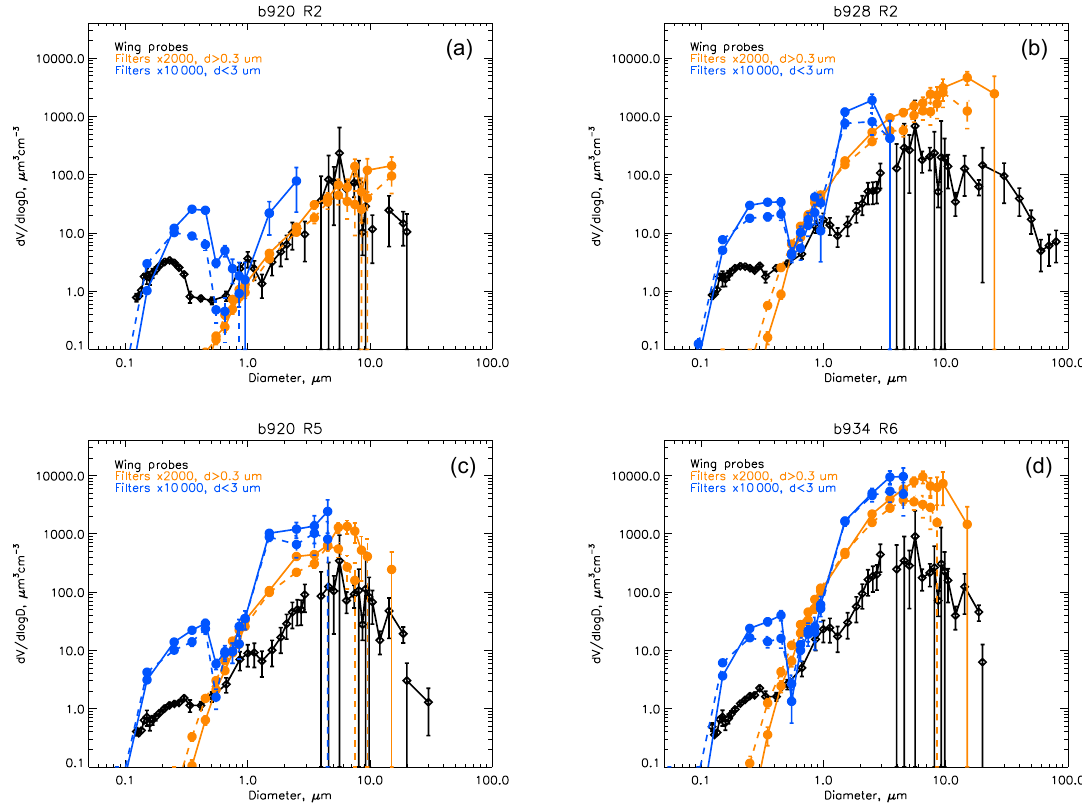
Figure 7. Comparison of wing probe size distributions with size distributions from filter samples at two magnifications (2000 and 10000) for four SLRs. Panels (a) and (b) show PSDs in the MBL without (a) and with (b) giant mode present; (c) and (d) show PSDs in the SAL. For filter PSDs, solid lines indicate volume distribution calculated assuming a spherical shape using an area-equivalent diameter. Dashed lines indicate volume distribution calculated using a height:maximum axis ratio of 1 : 3 (see text for more details).